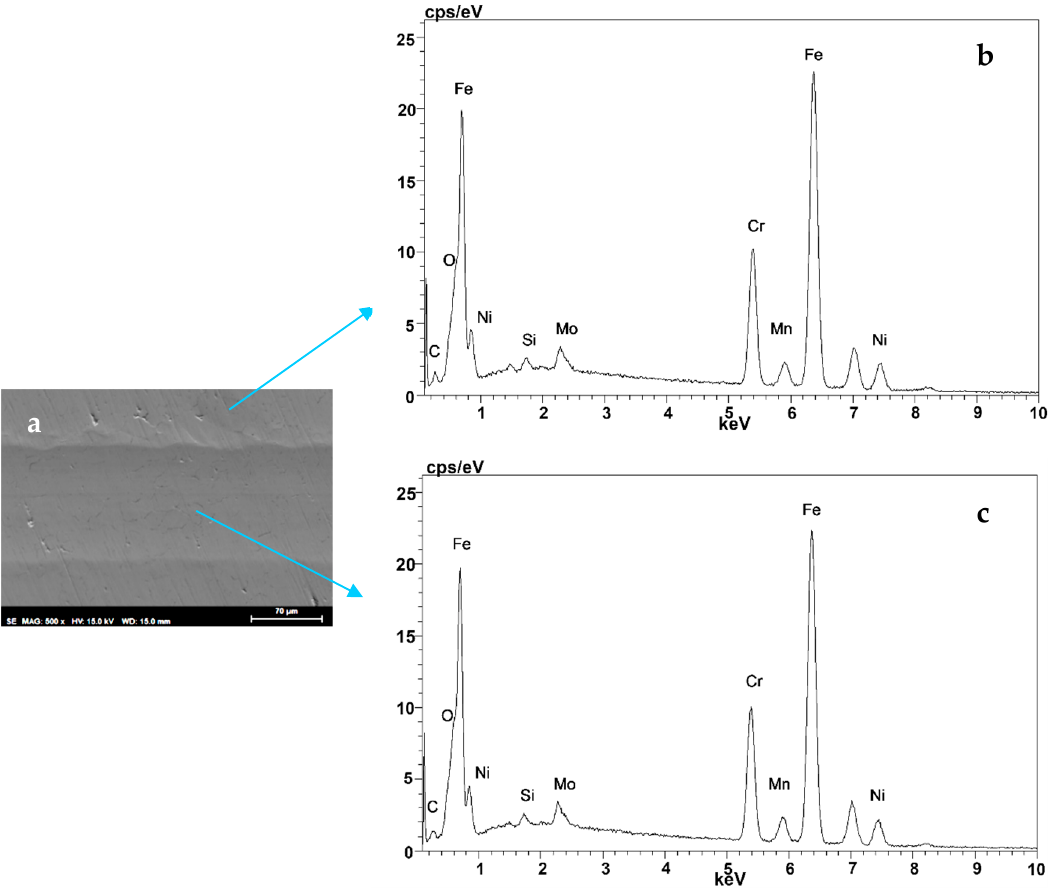
Figure 7. SEM micrograph of the wear scar on AISI 318L disk ( a ), and EDX spectra outside ( b ) and inside ( c ) the wear track.